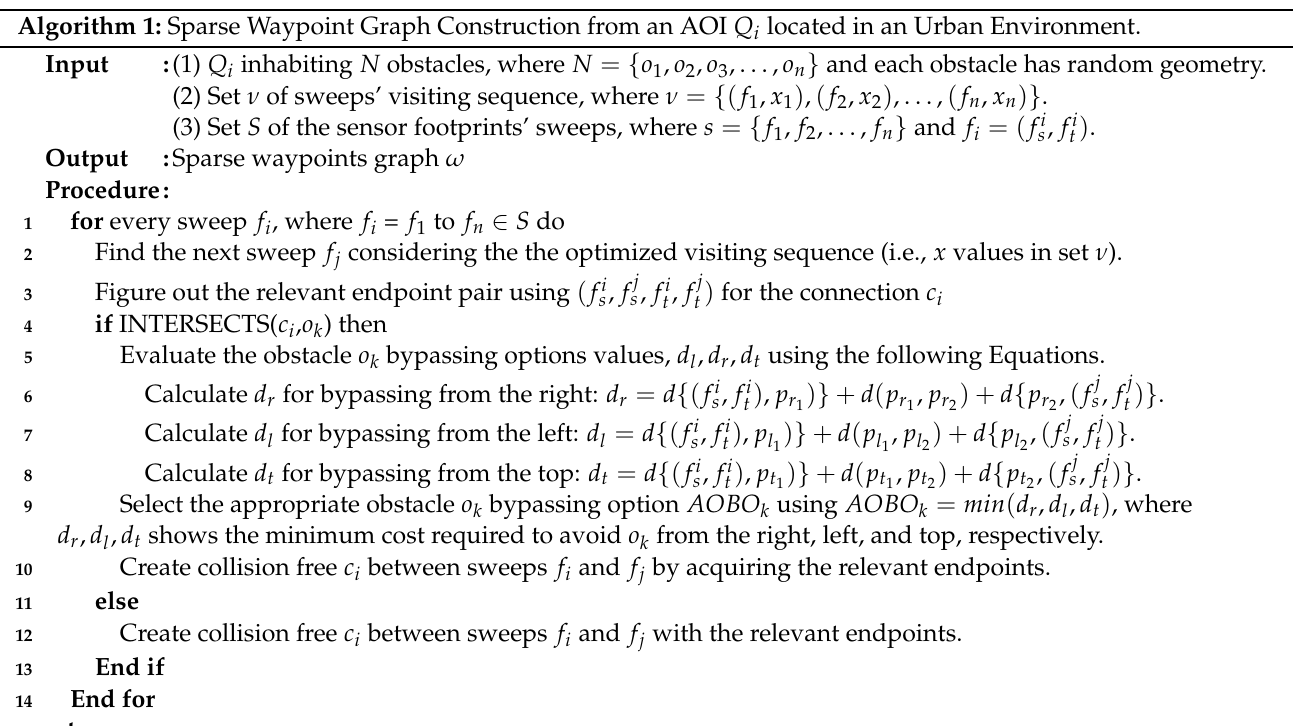
Algorithm 1: Sparse Waypoint Graph Construction from an AOI Q i located in an Urban Environment.